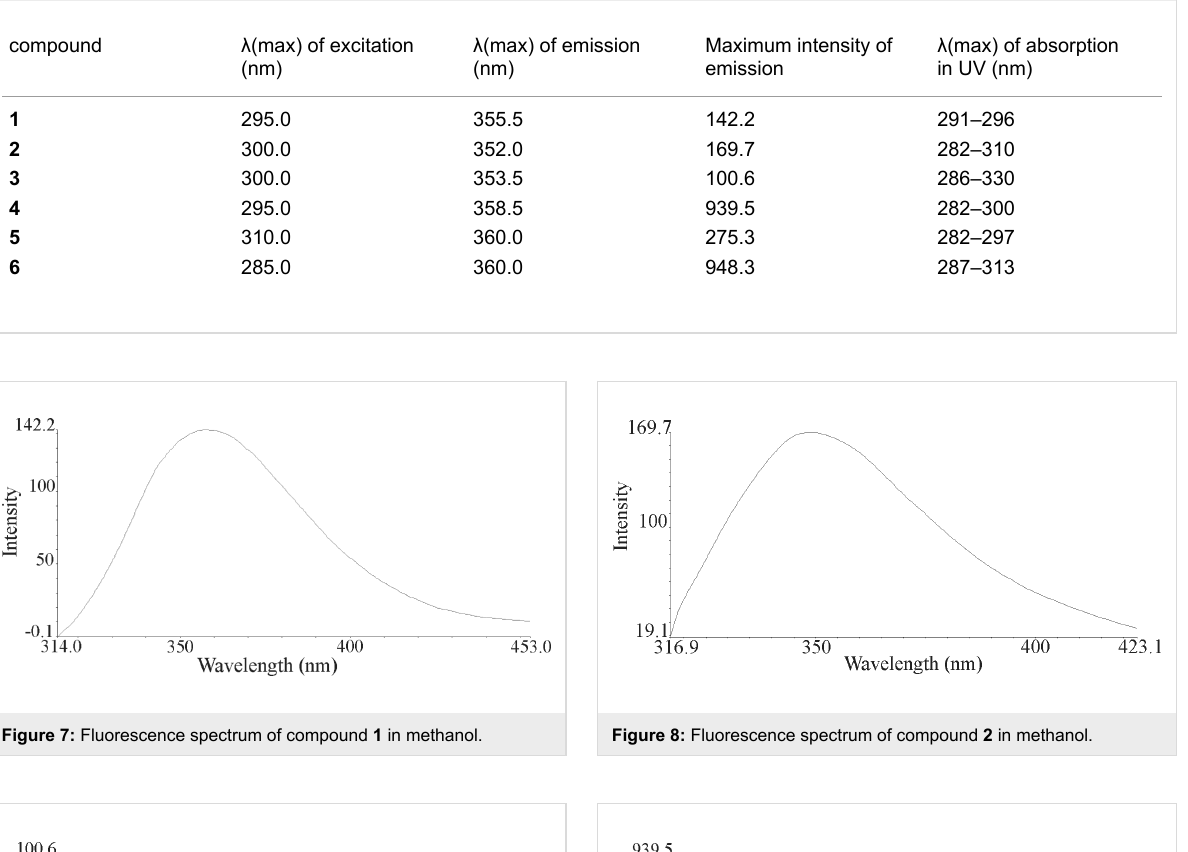
Table 2: The summary of fluorescence and UV spectra of compounds 1 – 6 .